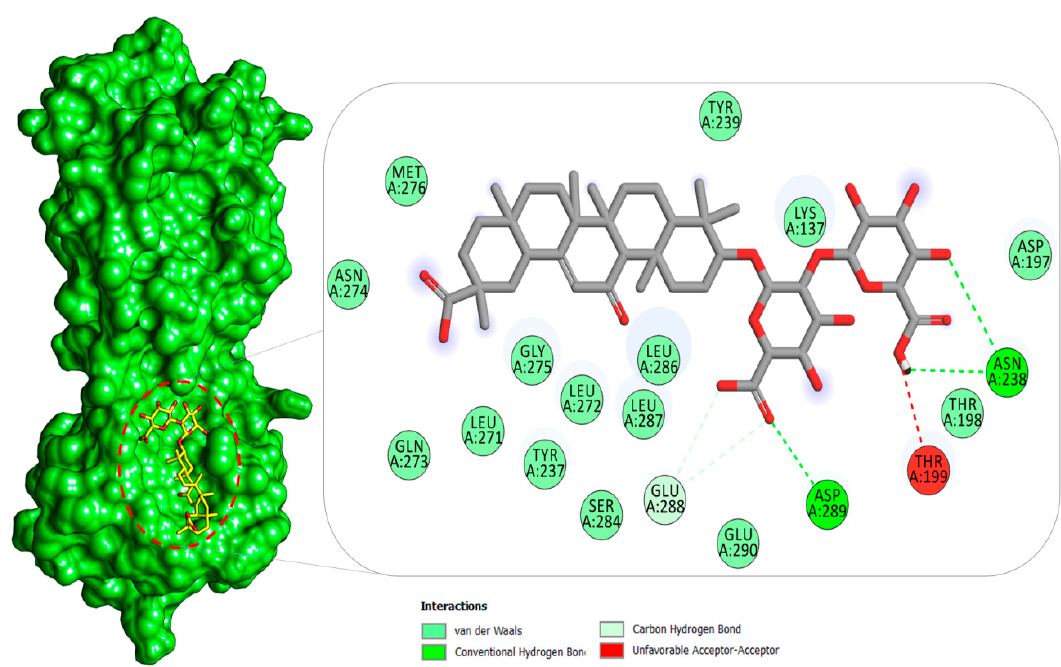
Figure 4. Binding pose of glycyrrhizin (in yellow stick) at the substrate binding pocket of Mpro (in the green surface). A 2D illustration of the glycyrrhizin chemical interactions at the docked site is also provided.